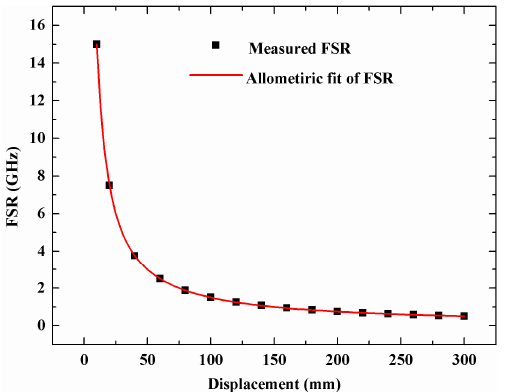
Figure 4. The relationship between the FSR and the displacement of the mirror.